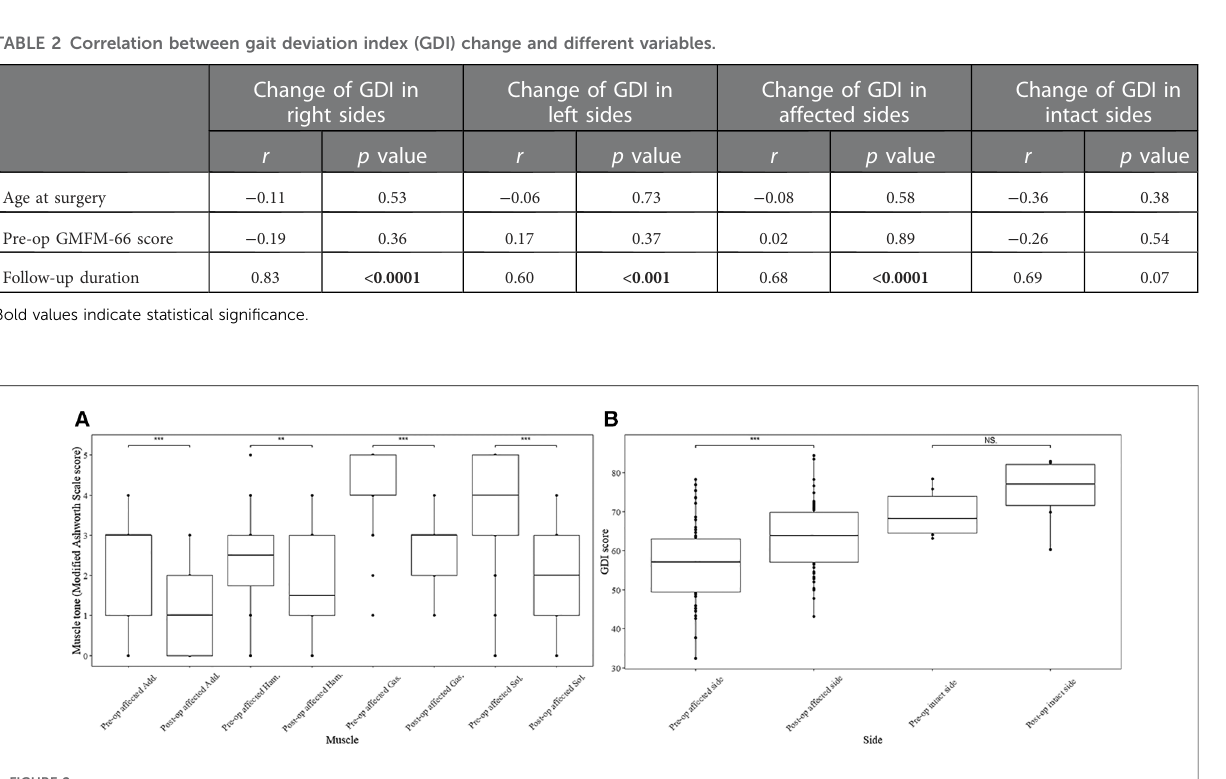
FIGURE 2 Muscle tone of muscles in affected limbs and GDI of both affected and intact limbs before and after SDR. Muscle tone change of muscles at affected sides after selective dorsal rhizotomy assessed by modi fi ed Ashworth Scale score ( A ) and the gait deviation index score change of both affected and intact limbs after the surgery ( B ). Add., adductors; Ham., hamstring; Gas., gastrocnemius; Sol., soleus; GDI, gait deviation index; SDR, selective dorsal rhizotomy; NS, no statistical signi fi cance. * p <0.05, ** p <0.01, *** p